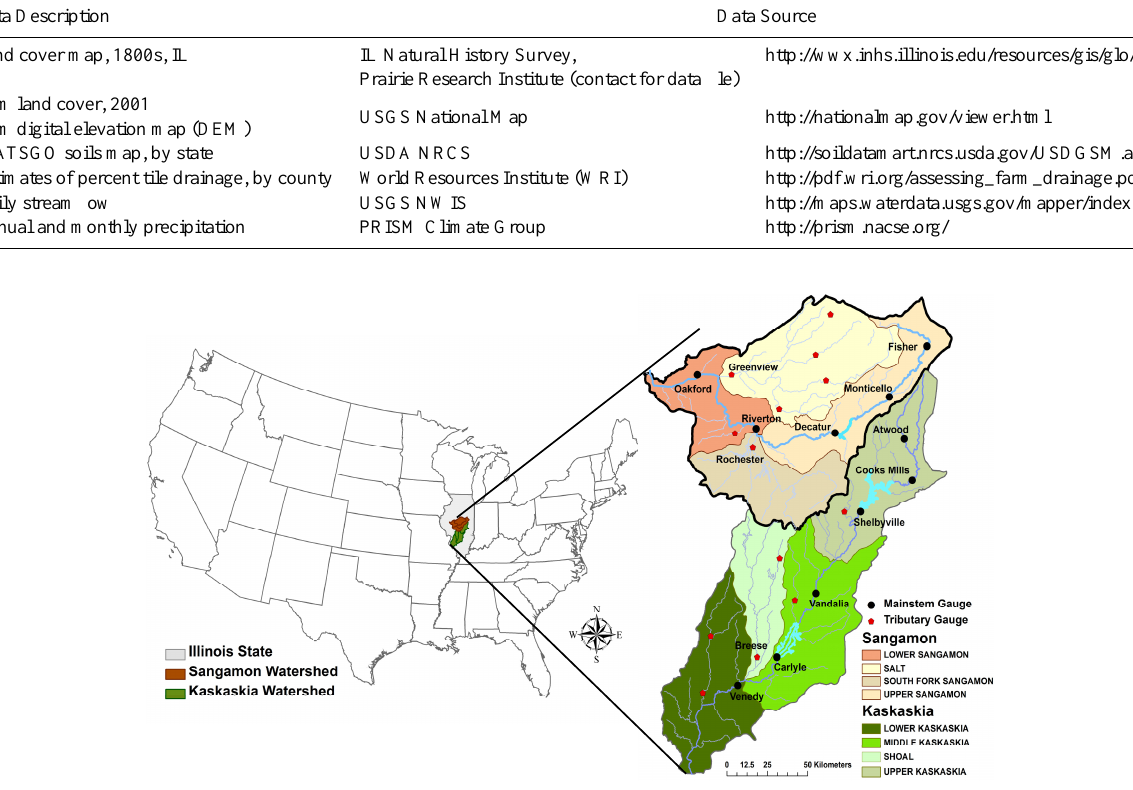
Fig. 2. Locator map for the Sangamon and Kaskaskia watersheds with gauge site and stream details.